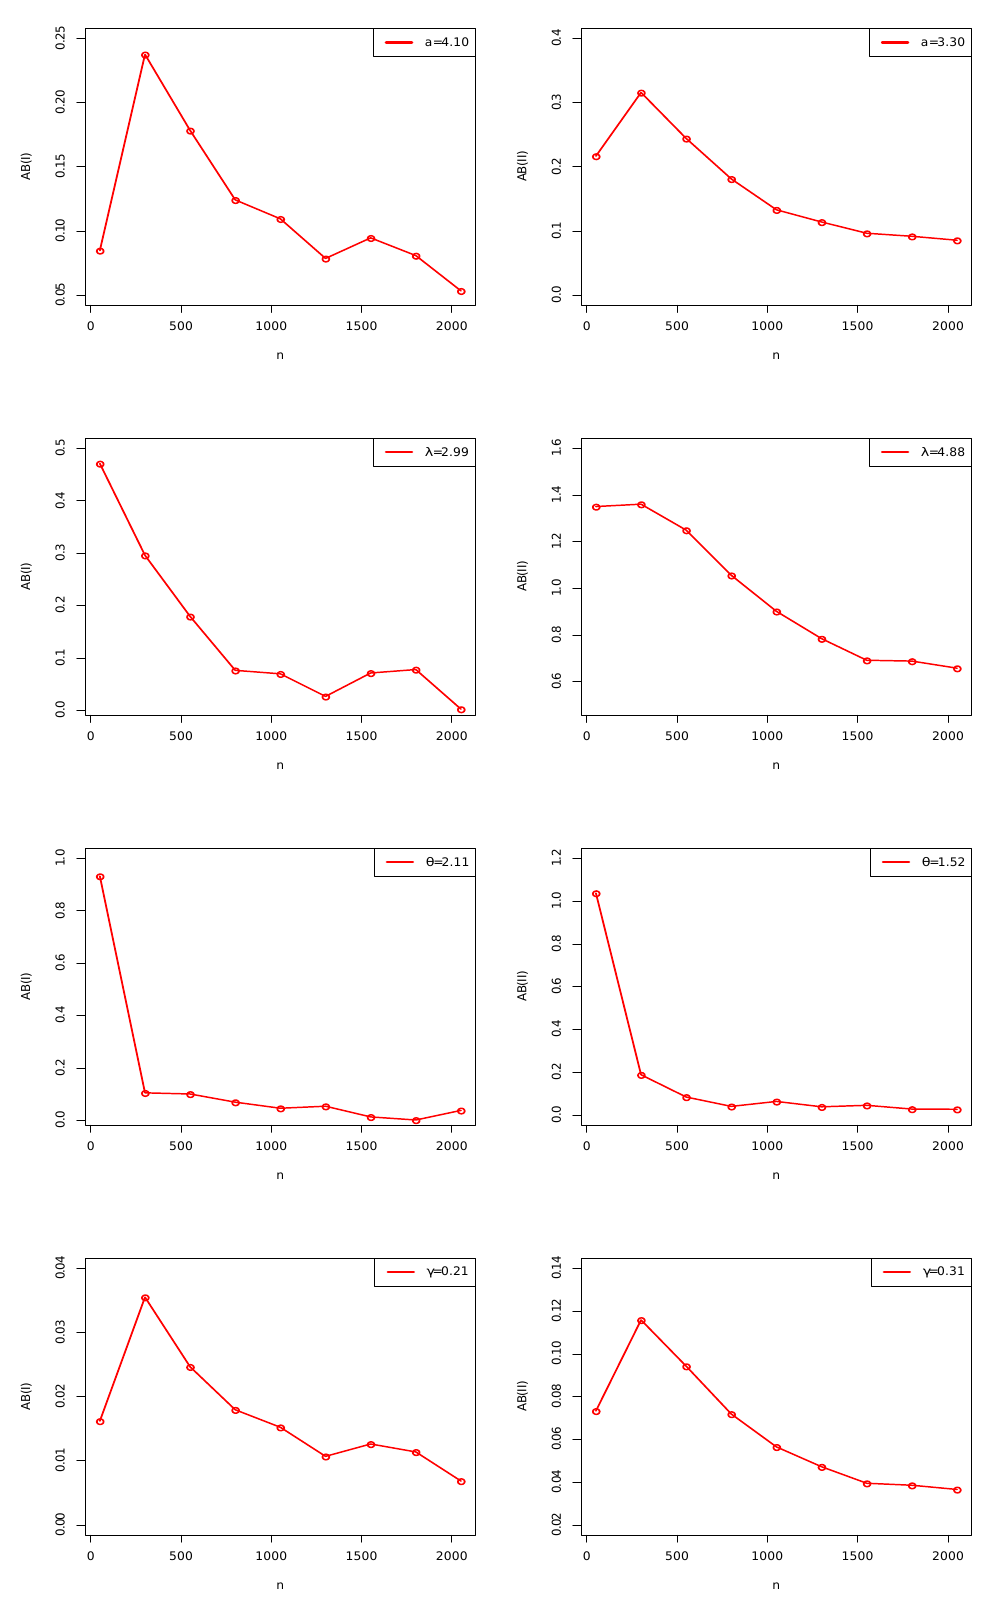
Figure 6. Estimated AB plots of NGE3ED in